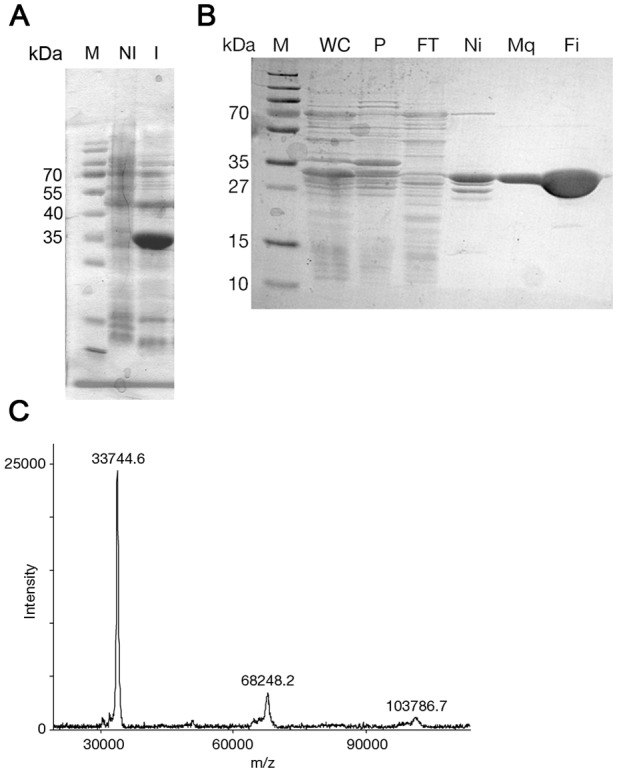
Expression and purification analysis of BteA287.(A) SDS-PAGE analysis of non-induced (NI) and IPTG-induced (I) samples that were taken from overnight grown cultures and were lysed by the addition of sample buffer followed by SDS-PAGE. (B) SDS-PAGE analysis of BteA287 Ni2+-affinity chromatography (AC) and anionic ion-exchange chromatography (IEC) purifications. Lanes are labeled as follows, M, marker; WC, whole cell lysate; P, pellet; FT, flow through; Ni, Elution from AC column; Mq, elution from IEC column; Fi, concentrated BteA287 sample. (C) MALDI/TOF-MS analysis of purified BteA287 with corresponding masses (in Daltons) indicated above main peaks.